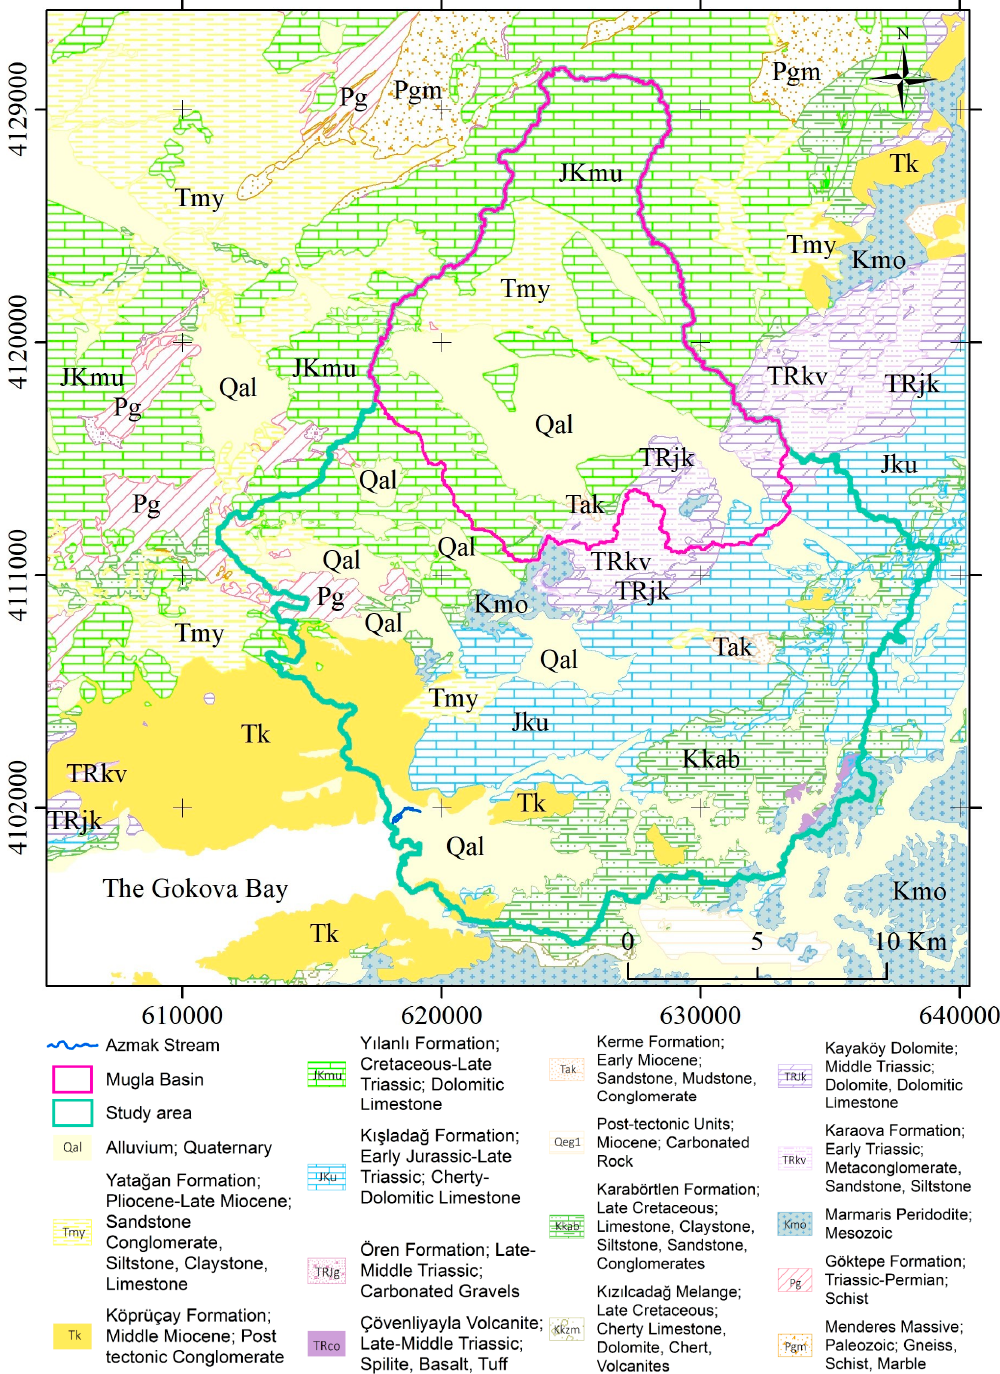
Figure 3. Geological map of the study area [44].